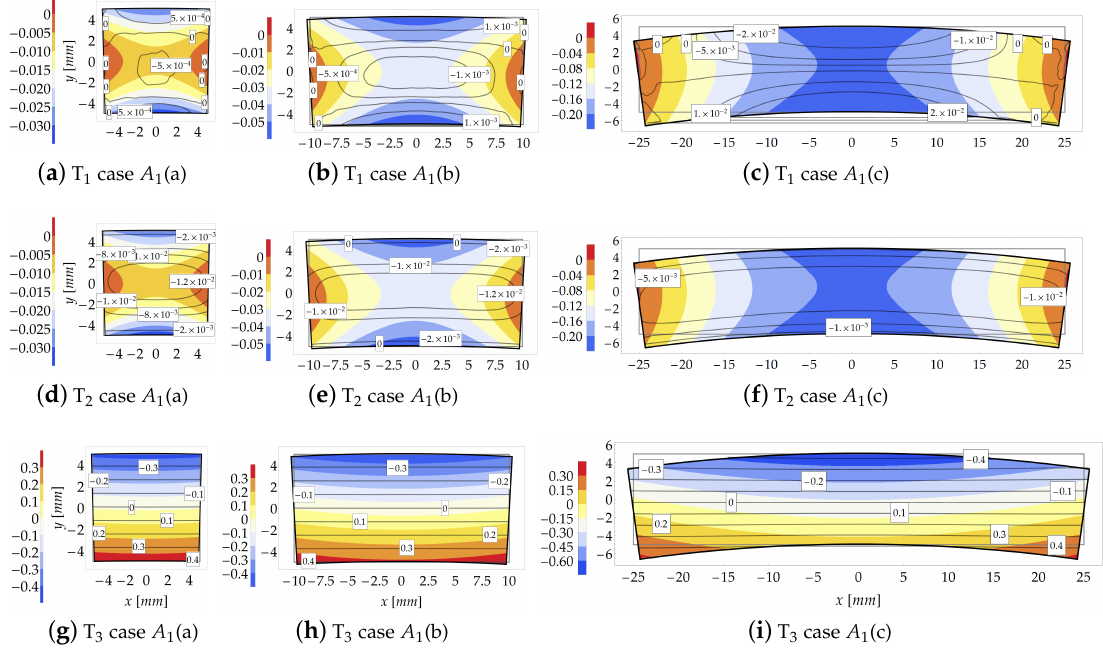
Figure 7. Study case A 1 ( b ) at load increment 3 ( µ = 100): Stresses comparison [MPa] between the theoretical model (contour plot) and FE model (isolines with boxed